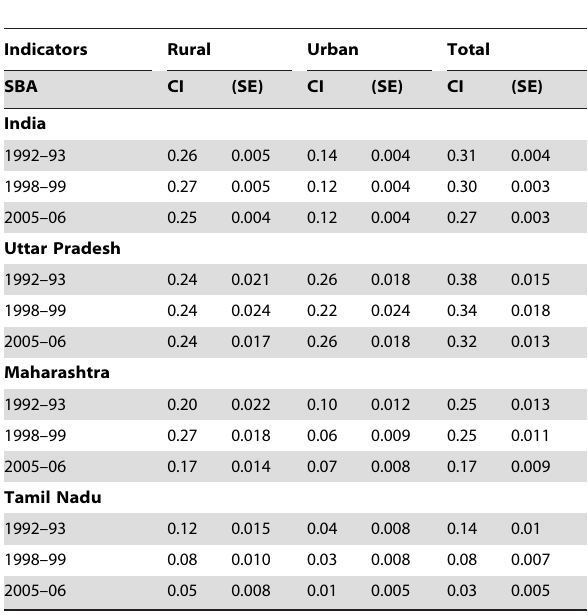
Table 4. Trends in economic inequalities in skilled birth attendance across selected states, India,